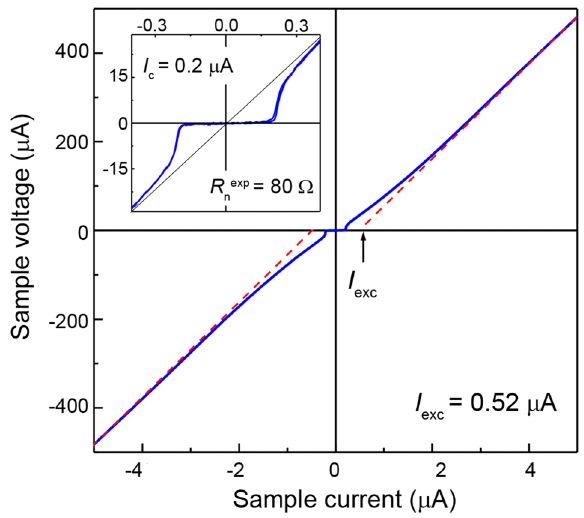
Fig. 4 Excess current effect observed in SJ1. Blue line: V ( I ) characteristics of SJ1 measured at 700 mK. Red dashed lines: extrapolated linear parts of the experimental V ( I ) curve at high currents determine the excess current I = 0.52 μ A. Black line in the inset: linear fi t of V ( I ) at low currents; its exc = 80 Ω for slope de fi nes R exp n